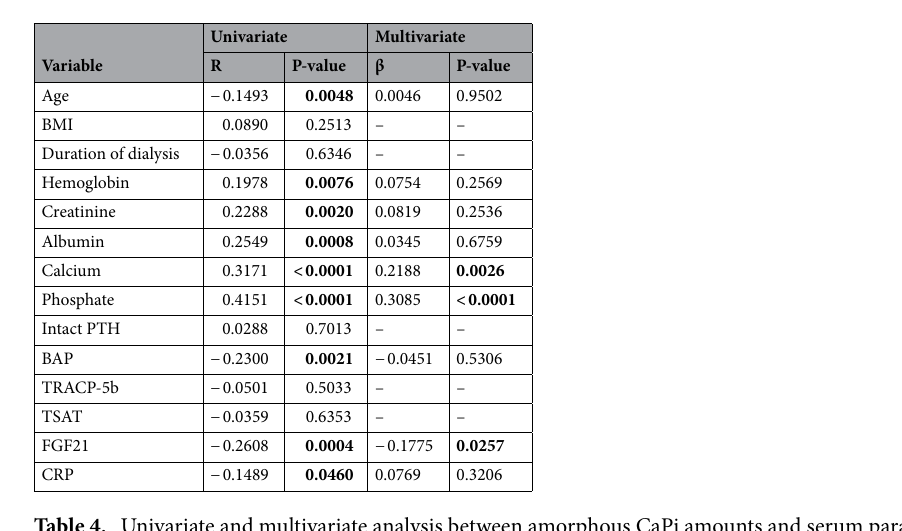
Table 4. Univariate and multivariate analysis between amorphous CaPi amounts and serum parameters in the hemodialysis patients. Significant values are in bold.